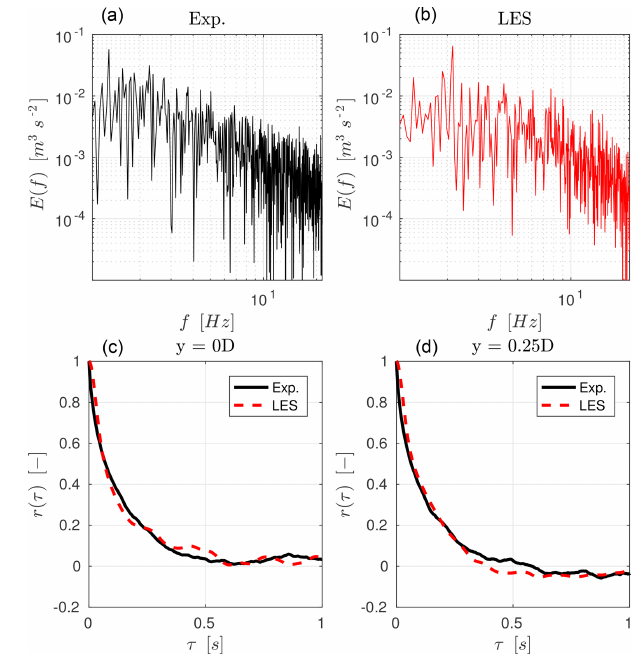
Figure 3. Turbulent kinetic energy spectrum E ( f ) at hub height 1.5D upstream of the rotor for the experiment ( a , black line) and simulation ( b , red line). Autocorrelation r ( τ ) at hub height 1.5D up- stream of the rotor (c) and 0.25D to its left, looking downstream (d)